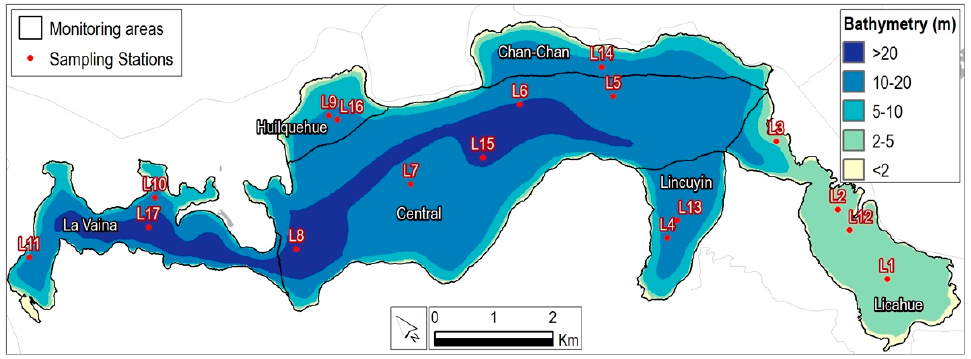
Figure 2. Sampling stations, bathymetry, and the six-unit segmentation of Lanalhue Lake.